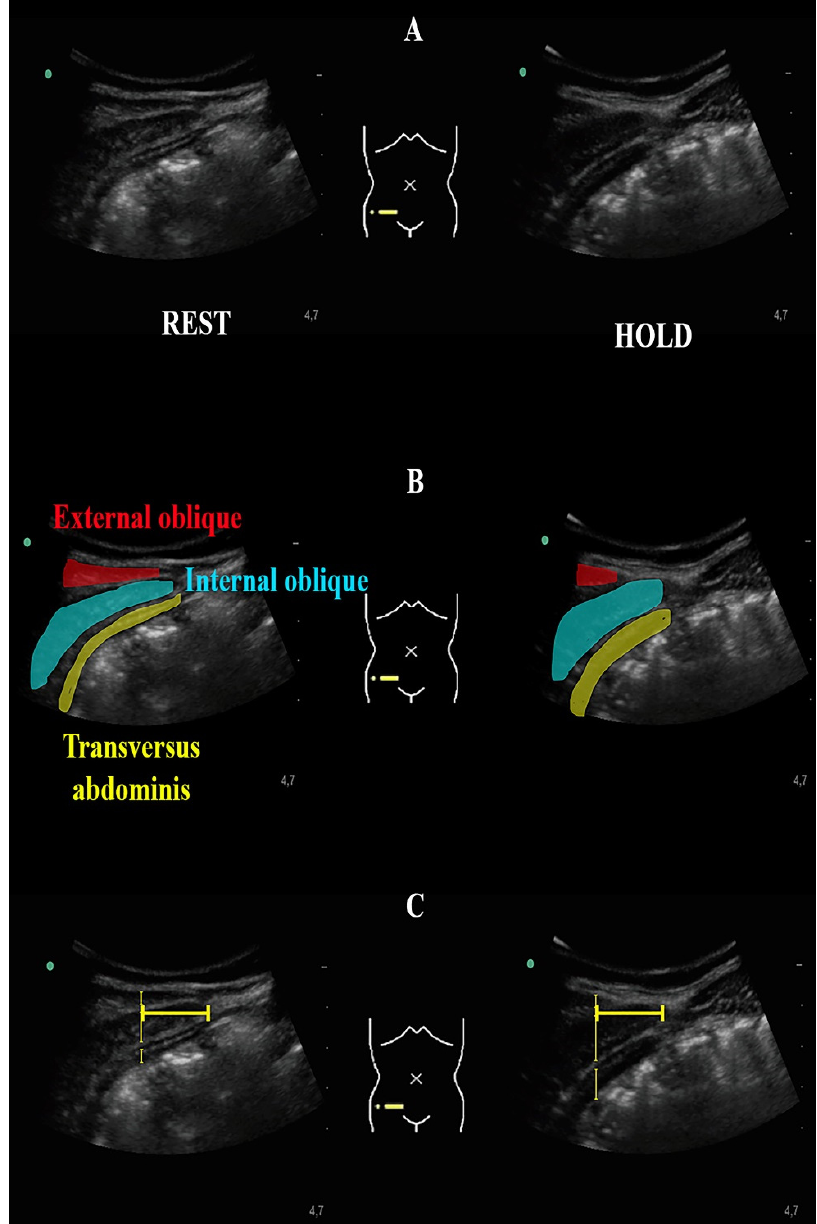
Figure 2. Ultrasound image of the deep abdominal muscles ( A ); Color mark of the deep abdominal muscles ( B ); Ultrasound measurements conducted in a vertical line located 3 cm lateral to the rectus sheath muscle-fascia junction (semilunaris line) ( C ).